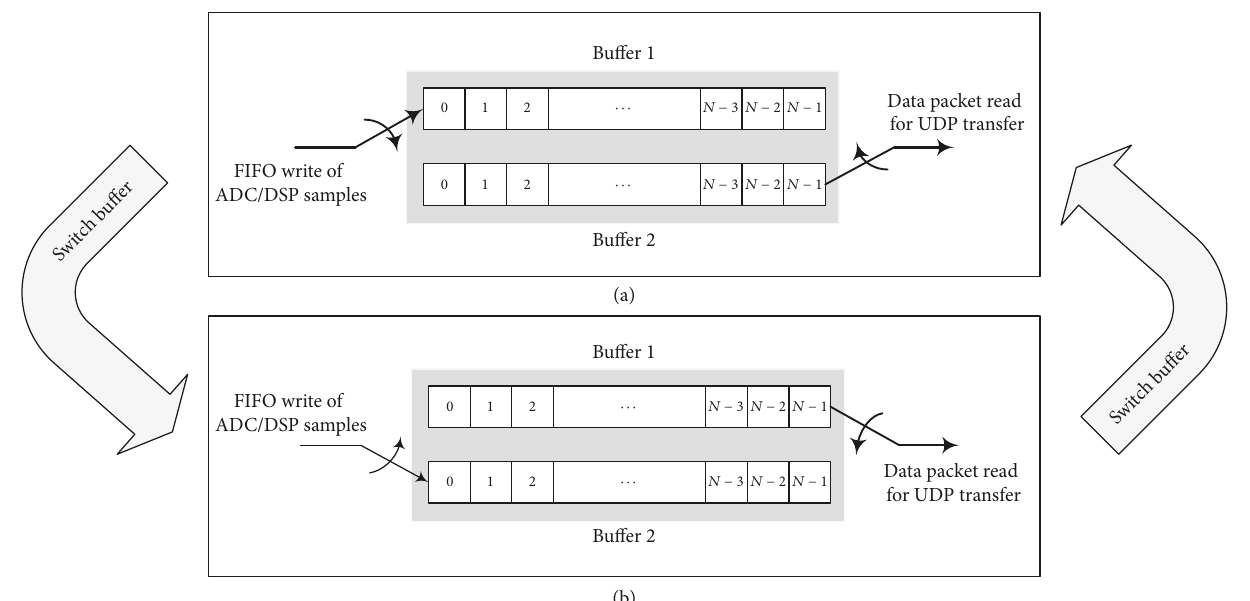
Figure 26: Double buffering used between the ADC or DSP output and Gbe input. (a) Writing DSP samples to BUFFER 1 and creating a data packet by concurrent reading of BUFFER 2 samples. (b) Writing DSP samples to BUFFER 2 and creating a data packet by concurrent reading of BUFFER 1 samples.